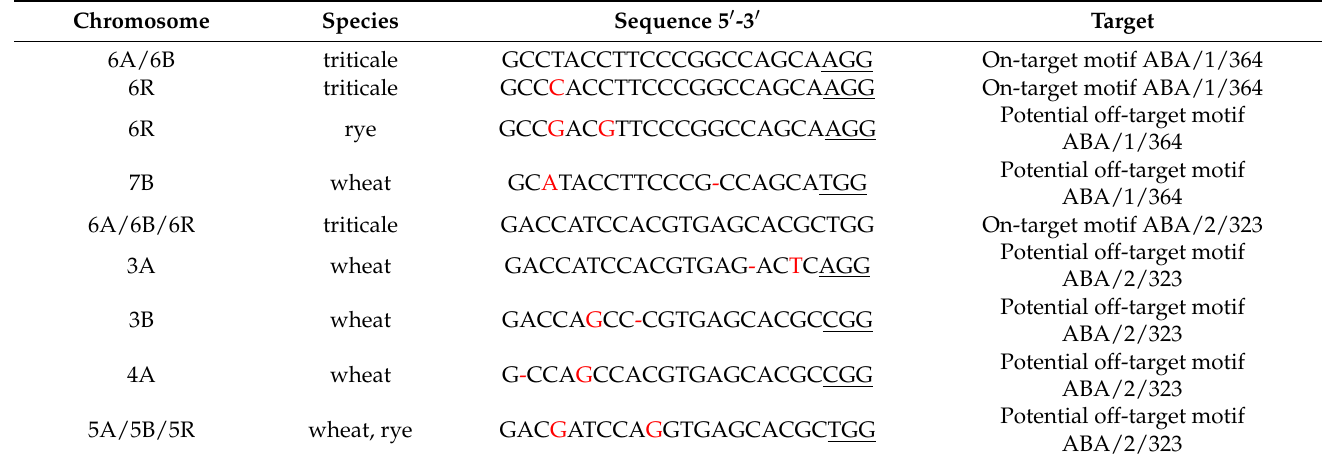
Table 1. Polymorphisms between on-target motifs and potential off-targets of the cas9/gRNA constructs used in this study. Predicted specificity of cas9/gRNA editing in triticale based on common wheat and rye genome induced off-target events. PAM sequence is underlined, mismatches as opposed to the target are indicated by red